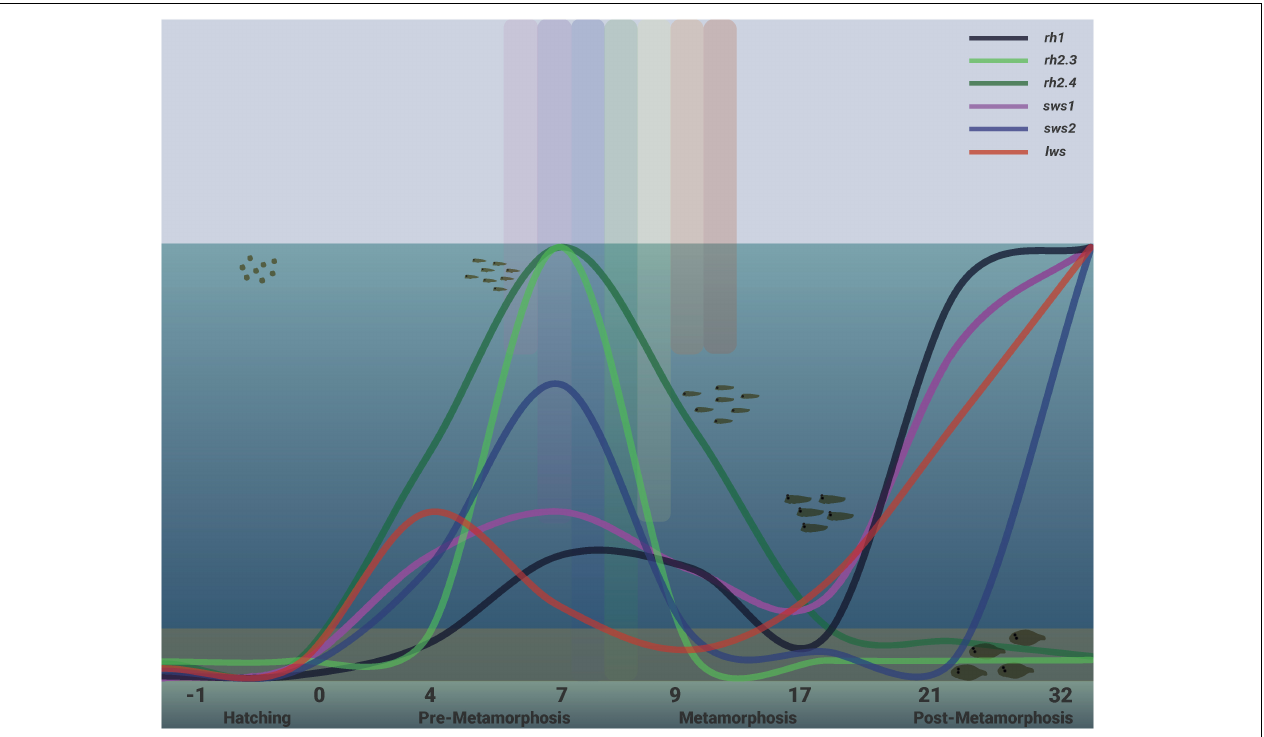
FIGURE 13 | Summary of the profile of visual opsins for rh1, sws1, sws2, rh2.3, rh2.4, and lws transcript levels obtained in this study in developing sole. This figure does not intend to compare expression levels among different opsins but the ontogenetic expression pattern for each visual photopigment. All the visual opsins exhibited early increase in expression during pre-metamorphosis and subsequent decrease in transcript levels during metamorphosis. Note how rh2.3 and rh2.4 green opsin expressions remain at low levels in post-metamorphic juvenile specimens. On the contrary, at this moment, all the other opsin transcript levels increase considerably. The different stages of Senegalese sole development analysed in this study by RT-qPCR are shown in this Figure (hatching, pre-metamorphosis, metamorphosis, and post-metamorphosis), indicating the position that specimens occupy in the water column in each stage. The differential penetration of lights of the visible spectrum into the ocean water column is also represented. Longer wavelengths, such as red light, are the first to be completely absorbed while shorter and medium wavelengths, such as blue and green lights, penetrate deeper. Eggs, embryos, and early larvae of the Senegalese sole live in the upper part of the water column, thus receiving irradiation that contains all wavelengths present in sun light. During metamorphosis, they start to migrate vertically to the bottom, receiving fewer wavelengths; finally, after the completion of the metamorphic process, they live in the seabed in an environment dominated by green and blue